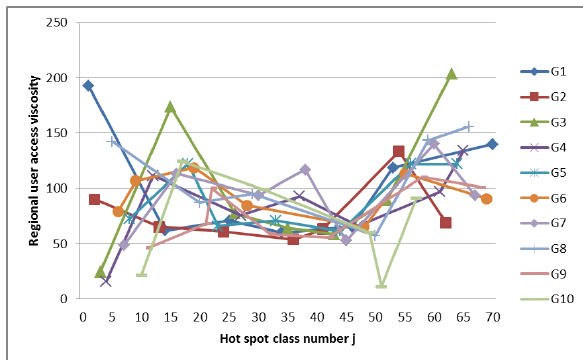
Figure 7. Regional user viscosity rate for hot